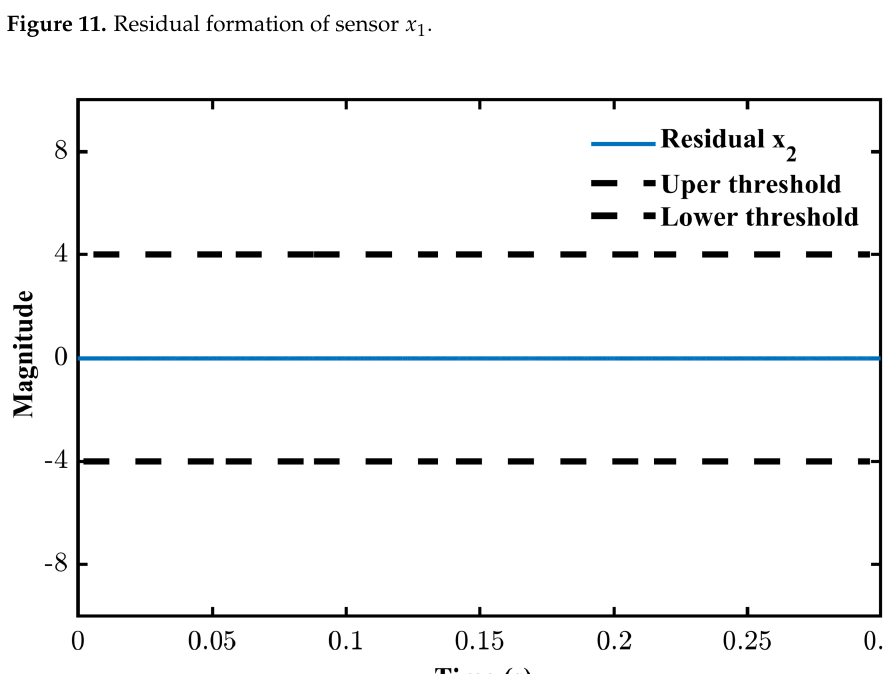
Figure 12. Residual formation of sensor x 2